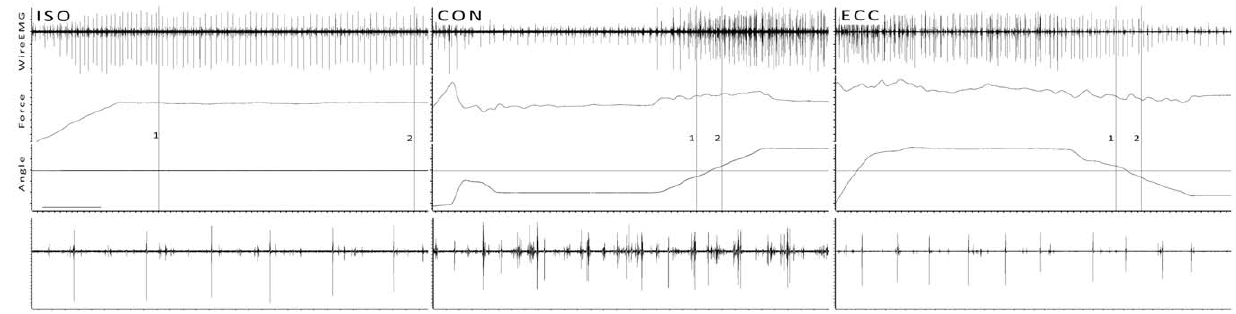
Figure 1. Examples of ISO, CON and ECC trials from one subject at 10% MVC. TOP: Cursors 1 and 2 mark the beginning and end of analysis, respectively. In dynamic contractions Cursor 1 is 200 ms prior and Cursor 2 200 ms after the angle crosses the angle of the ISO trial, as indicated by the horizontal cursor. BOTTOM: 400 ms close-ups of the wire EMG signal of each trial.